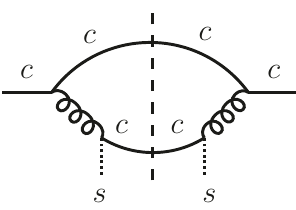
Figure 5 . Example of a one-collinear-particle reducible diagram, which does not contribute to the large- ω ( 0 ) behaviour of J c ( p 2 , ω, ω 0 )